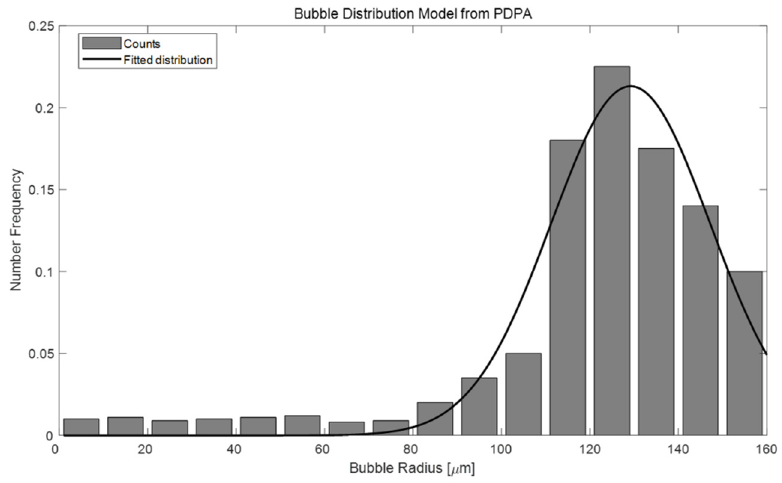
Figure 6. Artificial bubble distribution model measured by the PDPA.